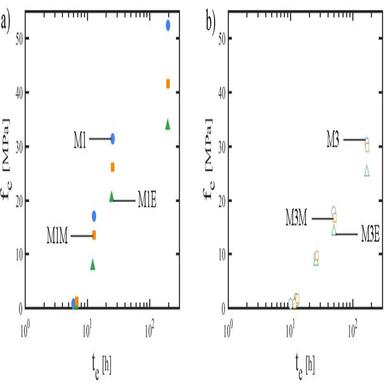
Compressive strength versus equivalent time for a) CEMI-based mortars and b) CEMIII/A-based mortars.